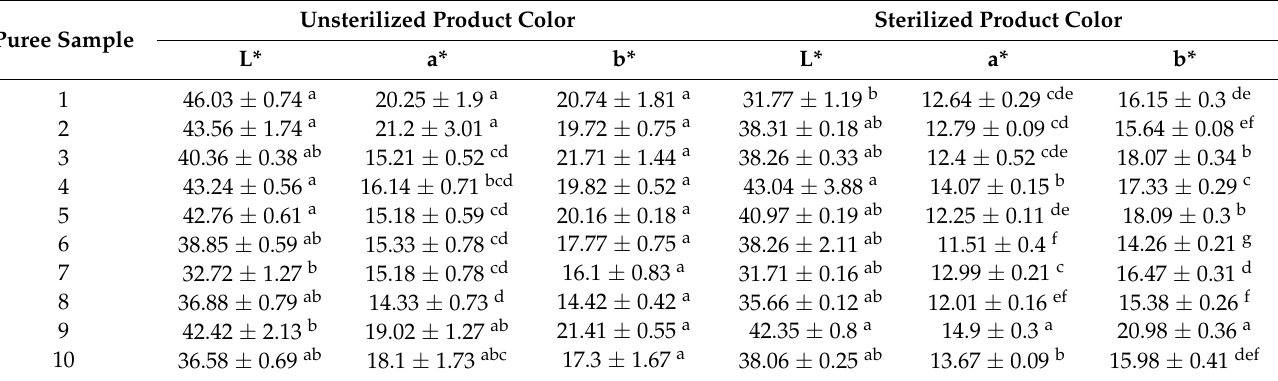
Table 6. Effect of thermal treatment on